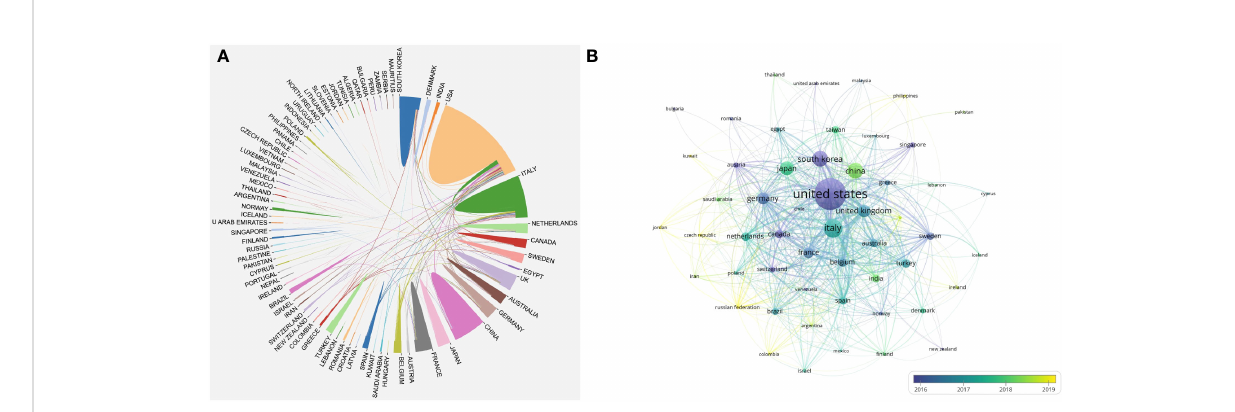
FIGURE 2 Knowledge map of national/regional collaborative network related to robotic surgery in oncology. (A) The map was produced by the Bibliometric Online Analysis Platform. (B) The size of the nodes is positively correlated with the number of countries/regions publications. The warmer the color of the nodes, the later the average publication time of the countries/regions. The lines between the nodes and the thickness of the lines represent the cooperation and cooperation intensity between the countries/regions. From: VOSviewer.